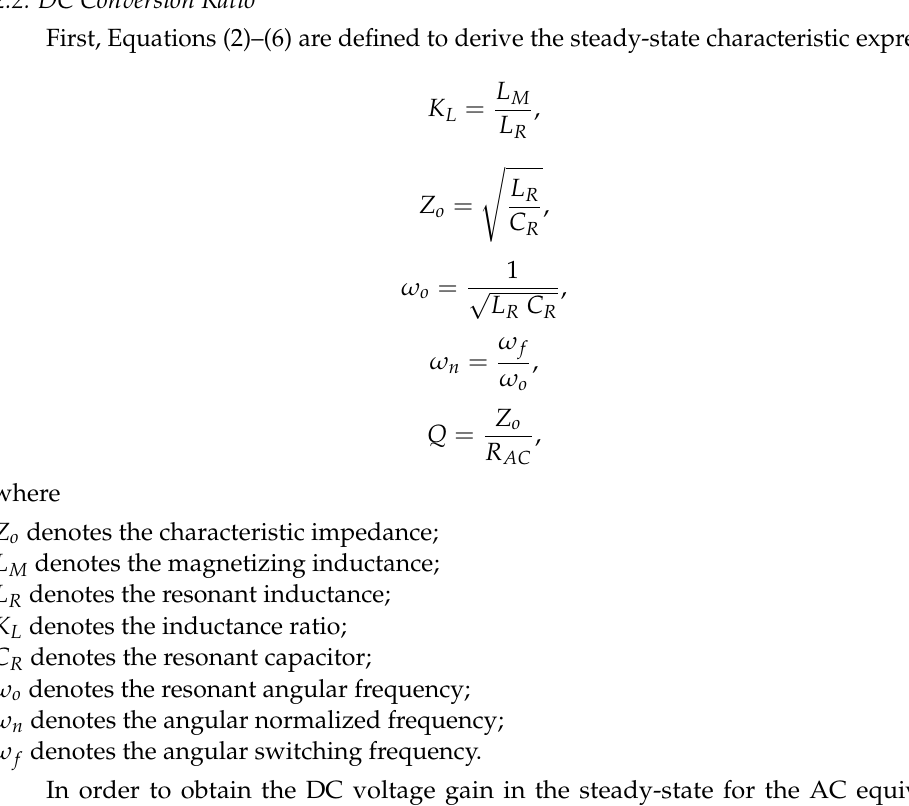
Figure 5. AC equivalent circuit of LLC resonant converter with internal loss resistance.